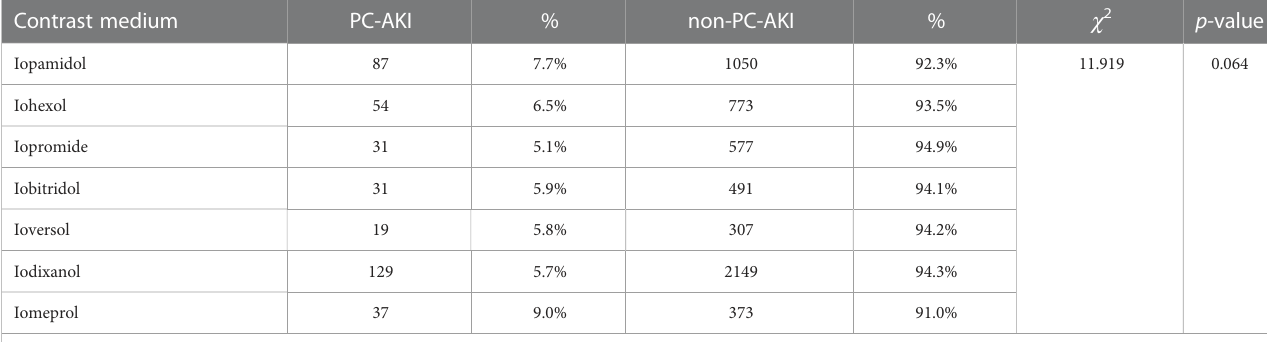
TABLE 3 Comparison of the incidence of PC-AKI caused by different iodine contrast mediums. Contrast medium